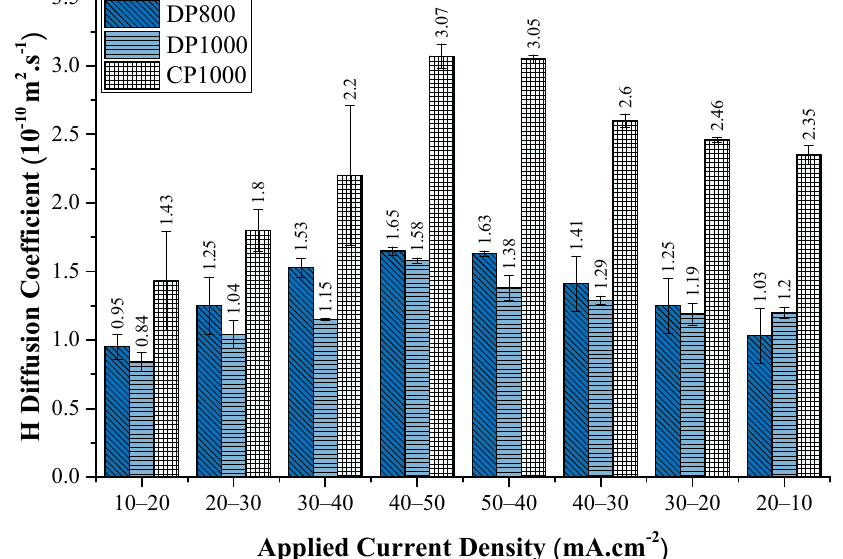
Figure 8. The evolution of the apparent diffusion coefficient of hydrogen in different steels investi- gated in this study, with the change in cathodic current density during the rise transient. The values indicate the mean diffusion coefficient value obtained for each transient. Error bars are standard deviation based on two to three